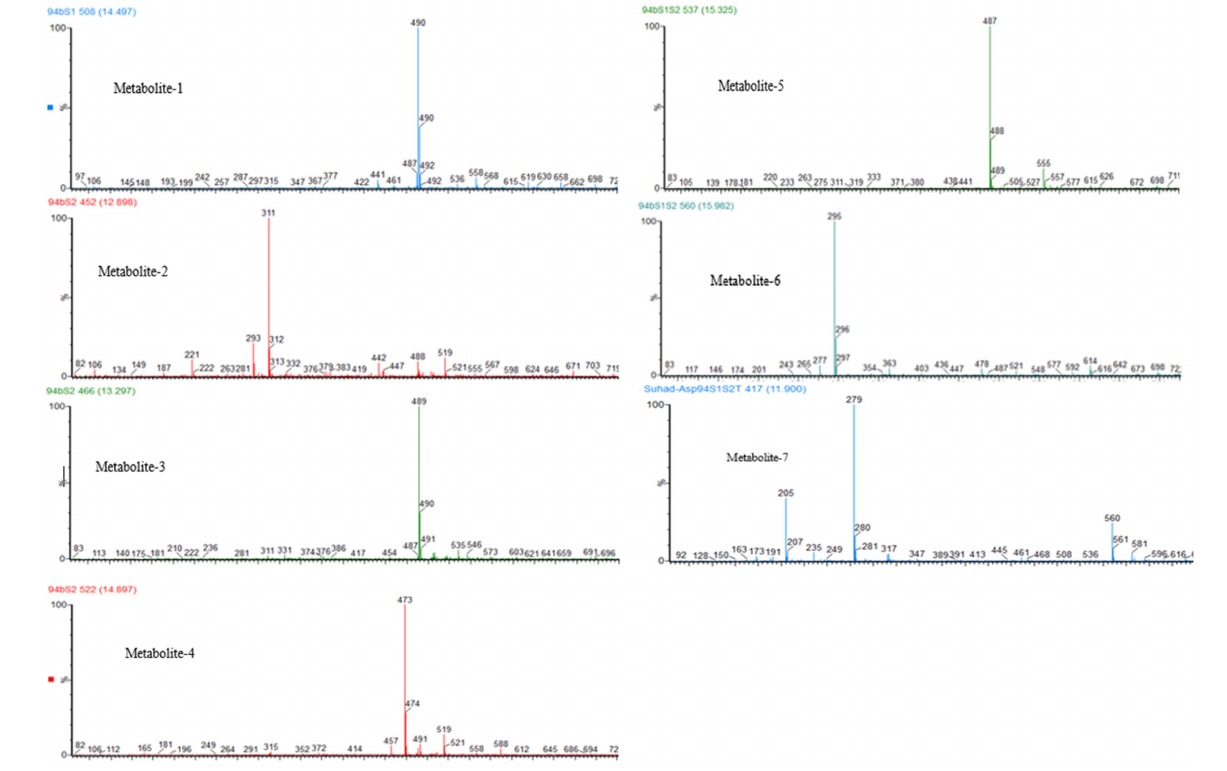
FIGURE 10 | Negative ESI mass spectra of NSAR1 transgenics. Seven new metabolites were detected as formate adduct [M++HCO 2 ] at: metabolite 1, m / z 490; metabolite 2, m / z 311; metabolite 3, m / z 489; metabolite 4, m / z 473; metabolite 5, m / z 487; metabolite 6, m / z 295; and metabolite 7, m / z